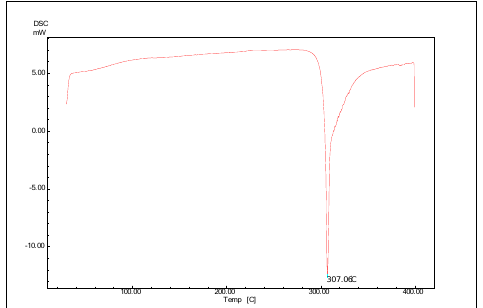
Figure 10. DSC thermogram of REM